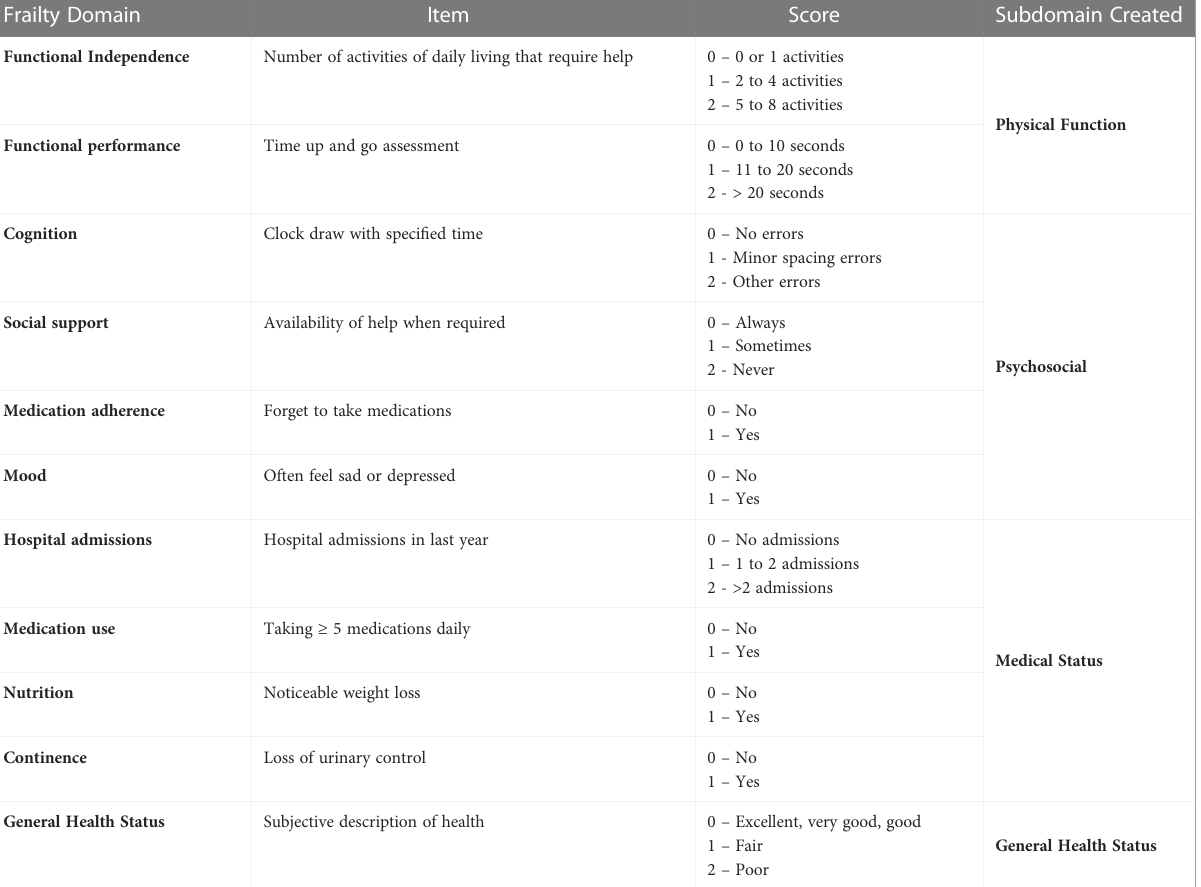
Table adapted from the Edmonton Frail scale fi rst developed and described by Rolfson et al. (2006) (20). The original EFS components were combined to create the following subdomians; physical function - functional independence and functional performance combined, psychosocial - cognition, social support, medication adherence and mood combined, medical status - hospital admissions, medication use, nutrition and continence combined. The General Health Status domain was retained as a seperate